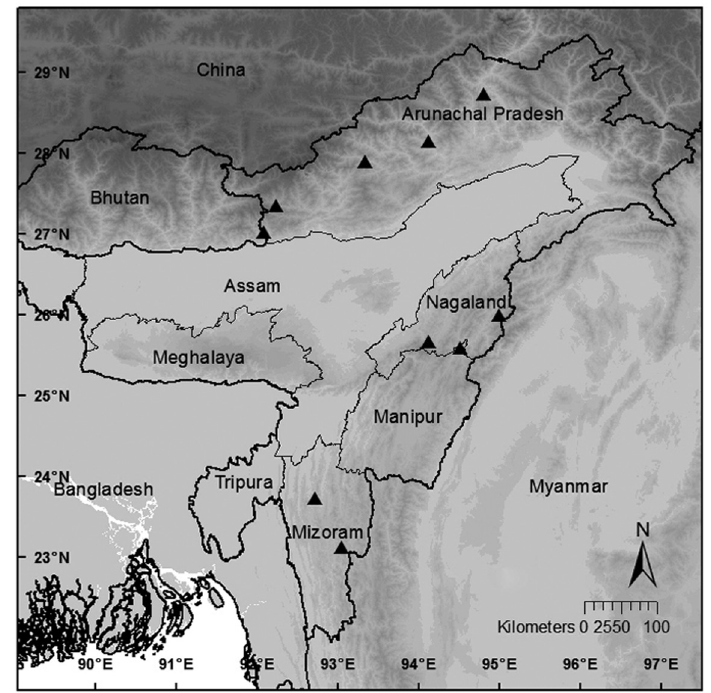
Fig. 57. Map showing the location of B. sikkimensis A.DC.